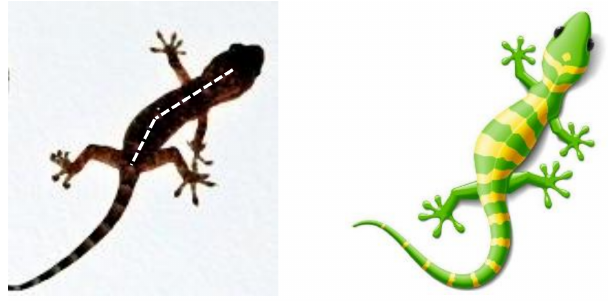
Figure 1. The lizards twist their trunks when